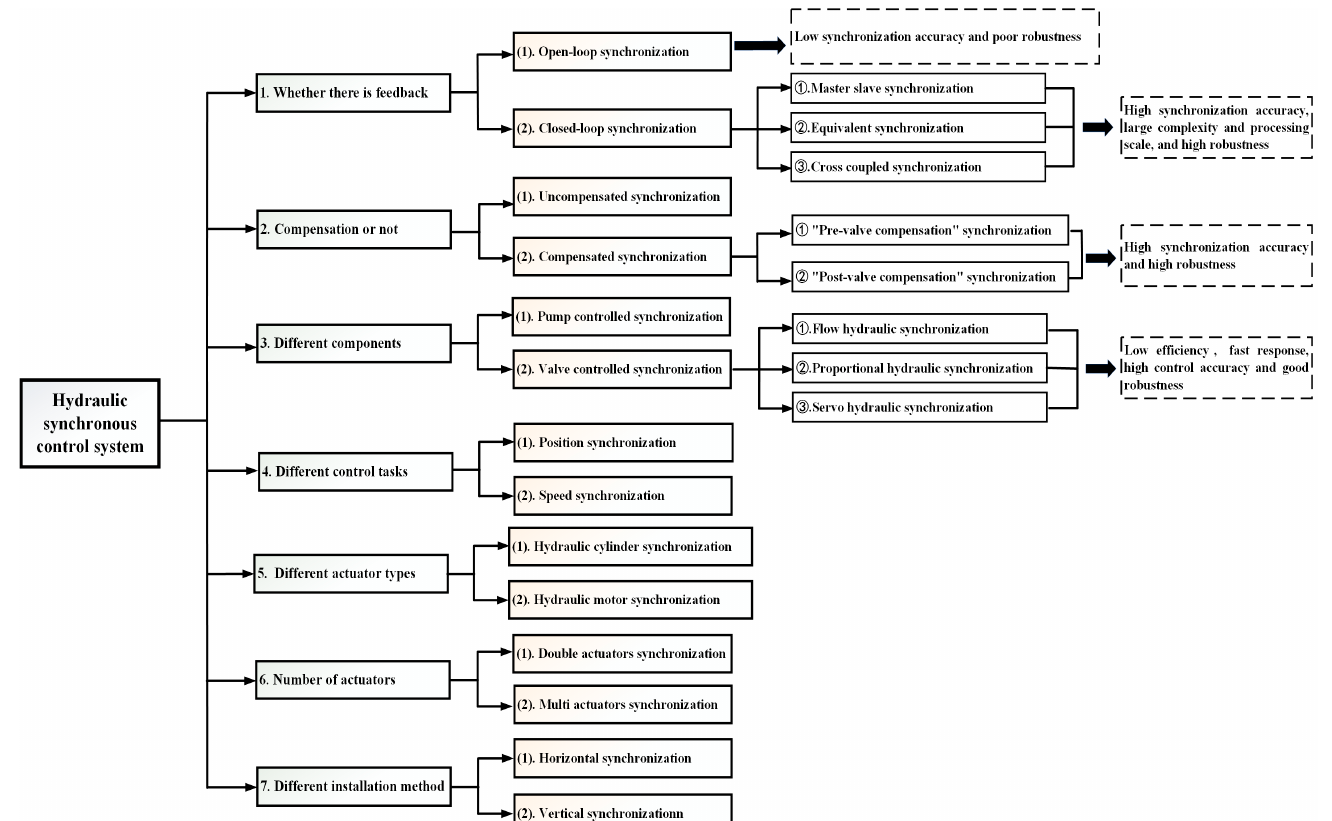
Figure 1. Classification diagram of hydraulic synchronous control system.